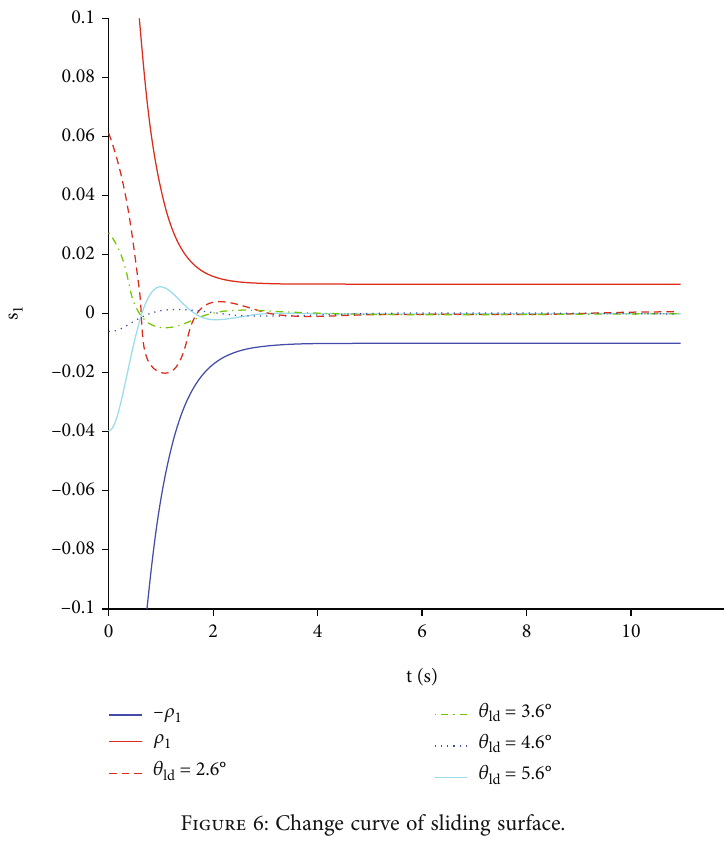
Figure 6: Change curve of sliding surface.